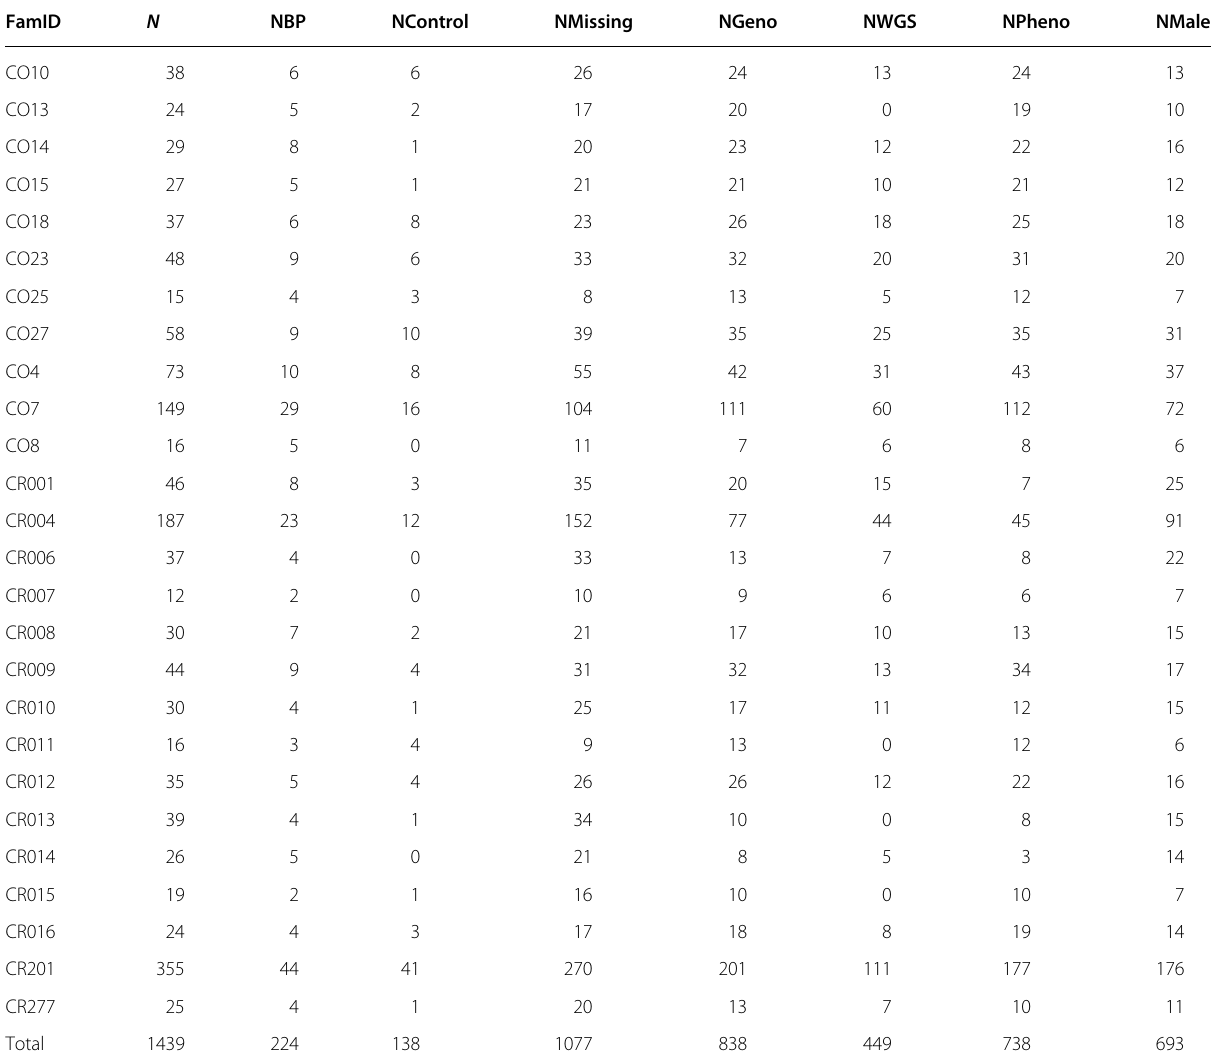
Table 1 Description of families included in the current study.